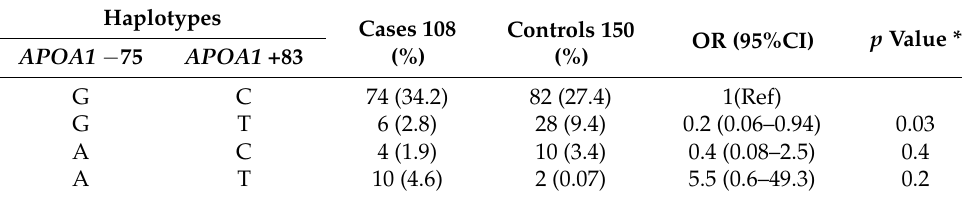
Table 3. Haplotype analysis of APOA1 − 75 G>A and +83 C>T for overall association with bladder tumor cases and healthy